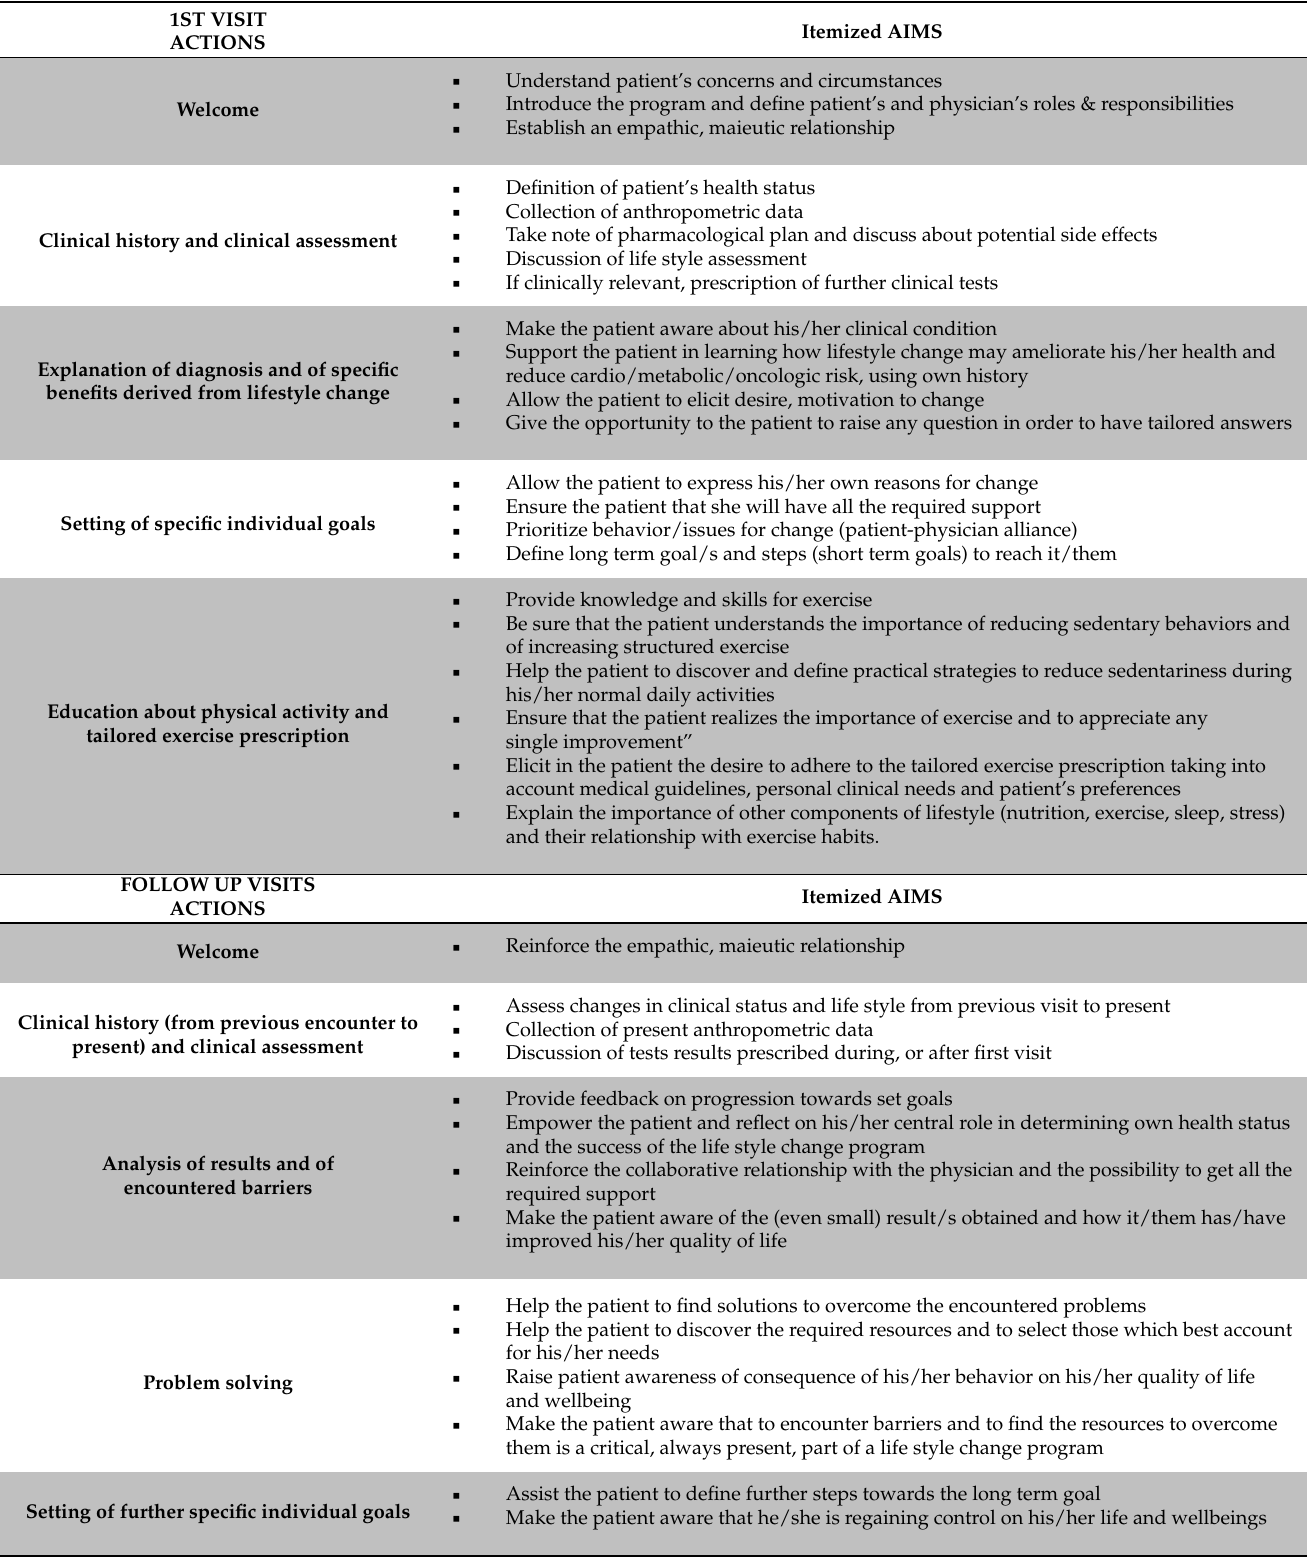
Table 4. Classification of physical activity intensity.